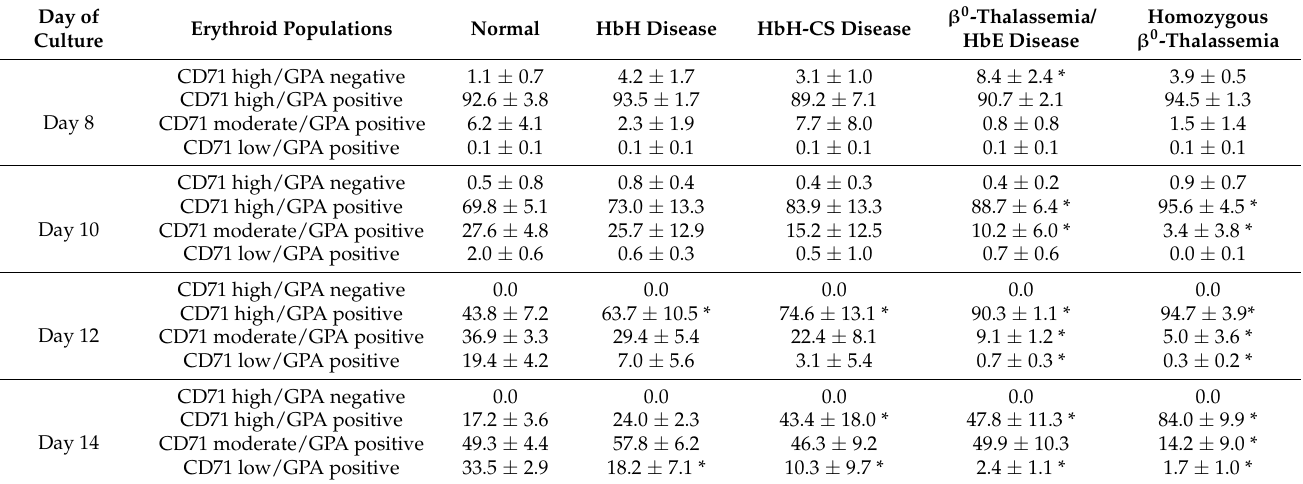
Table 2. Percentage of erythroid subsets of normal and different thalassemia types at different day of culture. * p ≤ 0.05 as compared to